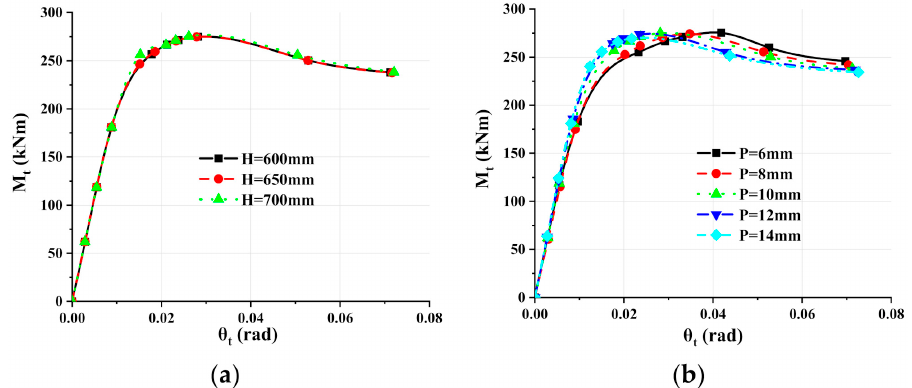
Figure 17. Moment-rotation curves: ( a ) The height of inbuild component; ( b ) The thickness of inbuild